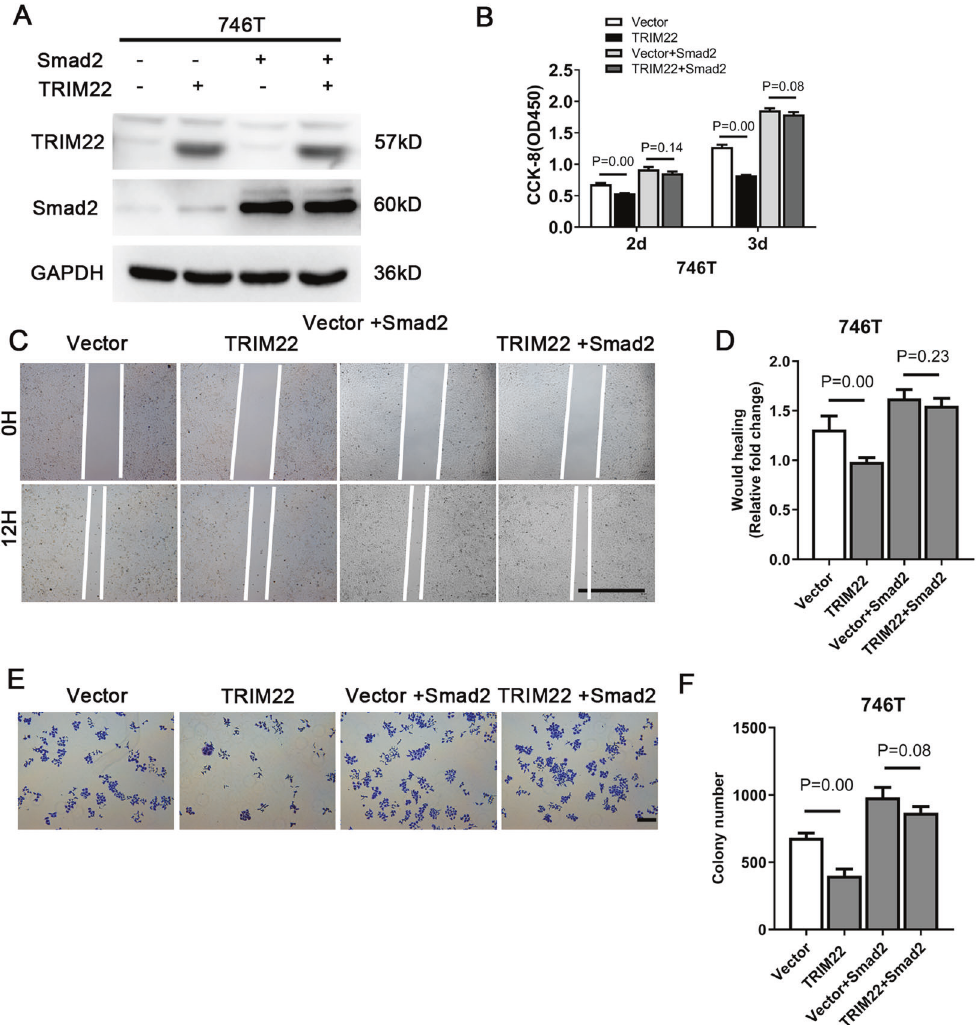
Fig. 5 Smad2 overexpression rescued the proliferation and migration effects of TRIM22 overexpression. A Protein expression in TRIM22 and Smad2 cotransfected cells (WB). B CCK-8 assay. C , D Wound healing assay, scale bars = 1000 μ m. E , F Colony formation assay, scale bars = 100 μ m. Data are shown as mean ± SD of three independent